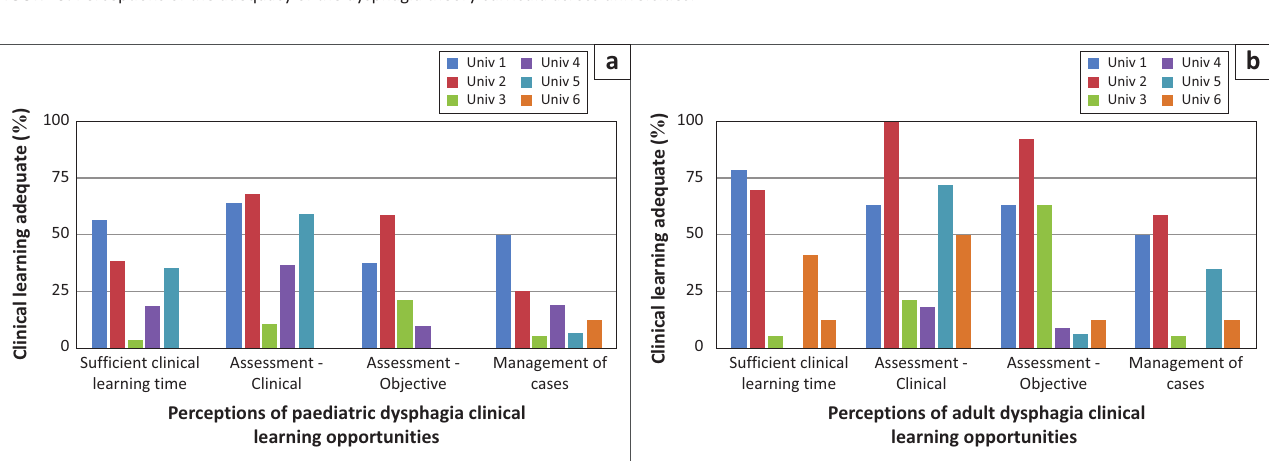
FIGURE 4: Perceptions of the adequacy of the clinical learning in dysphagia across